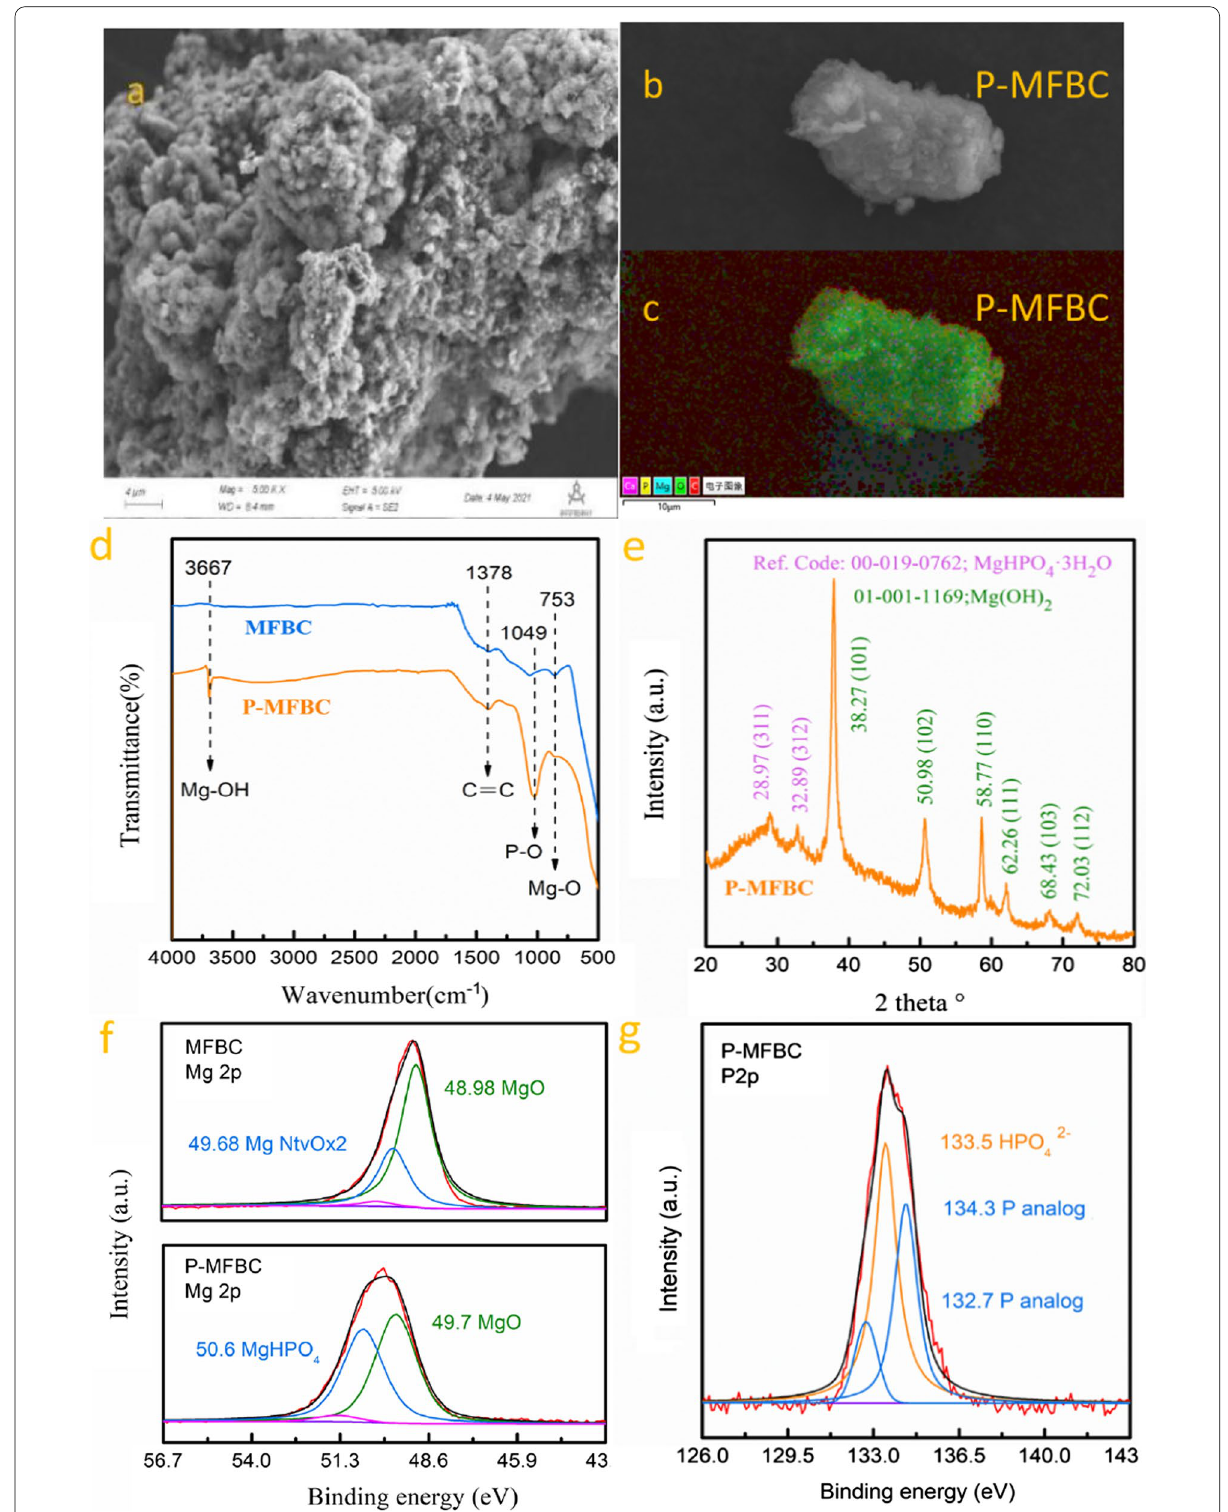
Fig. 5 SEM photographs of P-MFBC ( a ), selected SEM photograph area of P-MFBC ( b ) and related elemental distribution of the EDS-mapping ( c ), FT-IR ( d ) and XRD patterns ( e ) of P-MFBC, high resolution XPS spectra of Mg 1 s ( f ) and P2p of MFBC and P-MFBC samples ( g